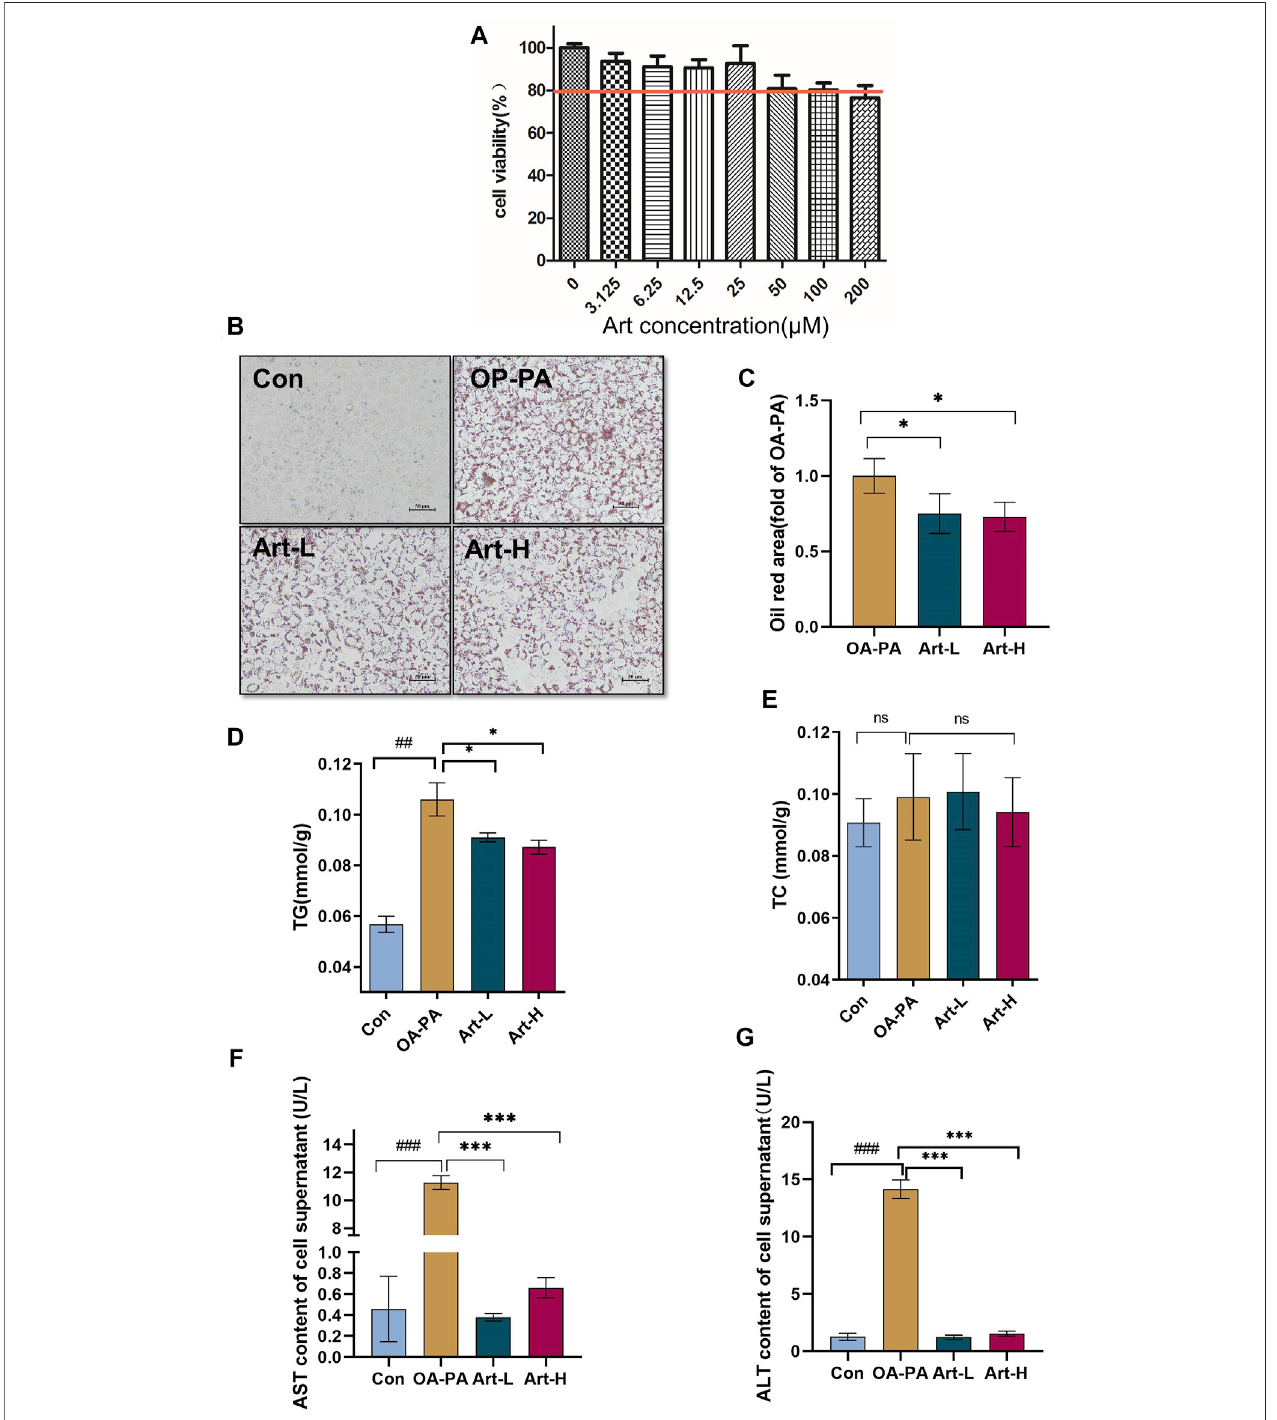
FIGURE 4 | Artemether treatment reduces lipid deposition in oleic and palmitic acid – treated cells. (A) Cytotoxicity effect of artemether treatment in the of HepG2 cells ( n = 6). (B) Images of oil red O staining of HepG2 cells that were treated with BSA (Con), 0.5 mM FFA mixture (OA-PA), 6.25 μ M Art along with 0.5 mM FFA (Art-L), and 25 μ M Art along with 0.5 mM FFA mixture (Art-H). (C) Quanti fi cation of oil red O staining with ImageJ. (D) Intracellular triglyceride level. (E) Intracellular cholesterol level. (F,G) AST (F) and ALT (G) levels in the supernatant of HepG2 cells. ( n = 3). Con vs. OA-PA: # p < 0.05; ## p < 0.01, and ### p < 0.001. OA-PA compared with Art-L and Art-H: * p < 0.05, ** p < 0.01, and *** p < 0.001.